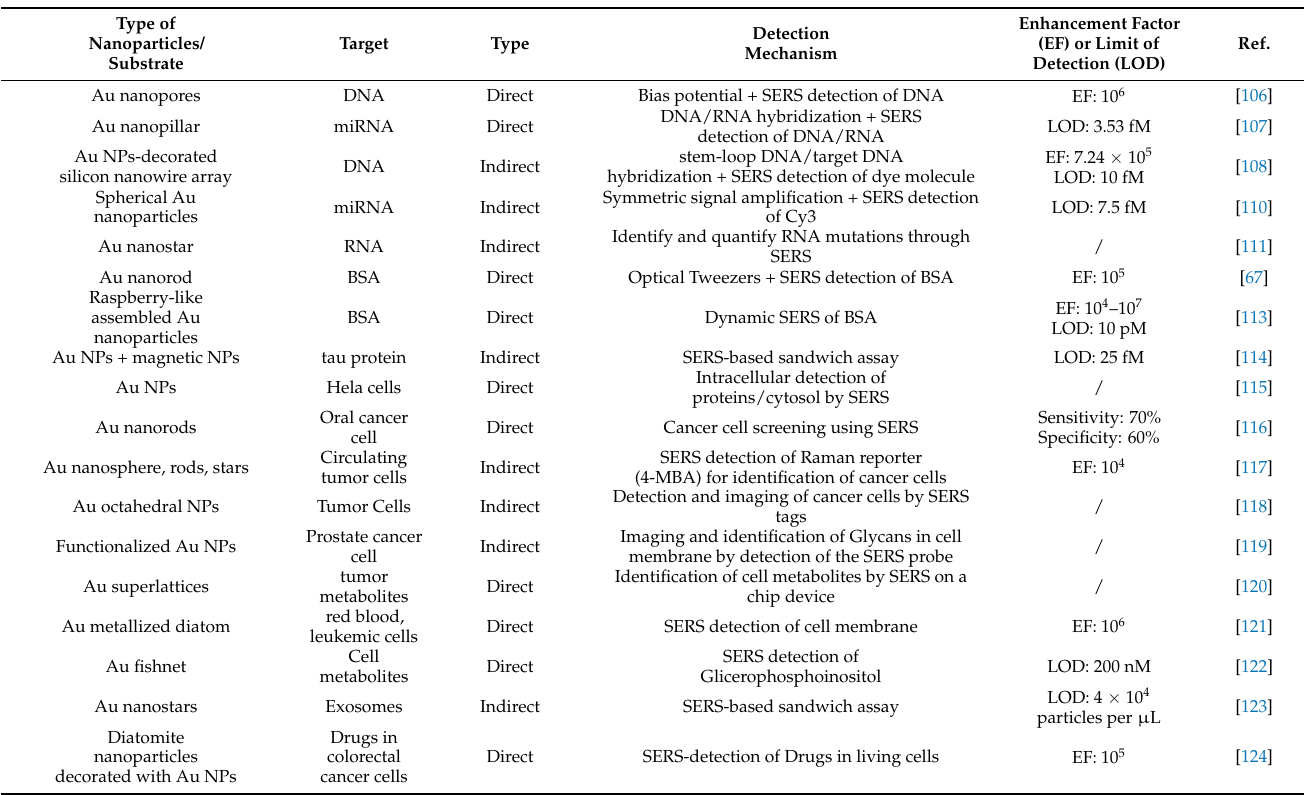
Table 2. A brief summary on biosensing using